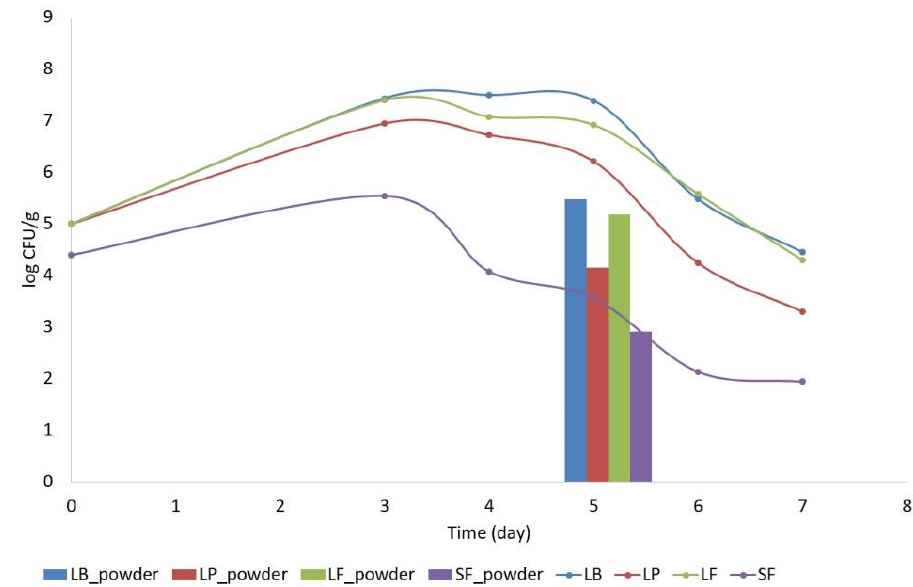
Figure 2. Content of lactic acid bacteria during 7 days of juice fermentation and in spray-dried pow- ders. SF — spontaneous fermentation, LB — Levilactobacillus brevis , LF — Limosilactobacillus fermentum , LP — Lactiplantibacillus plantarum.